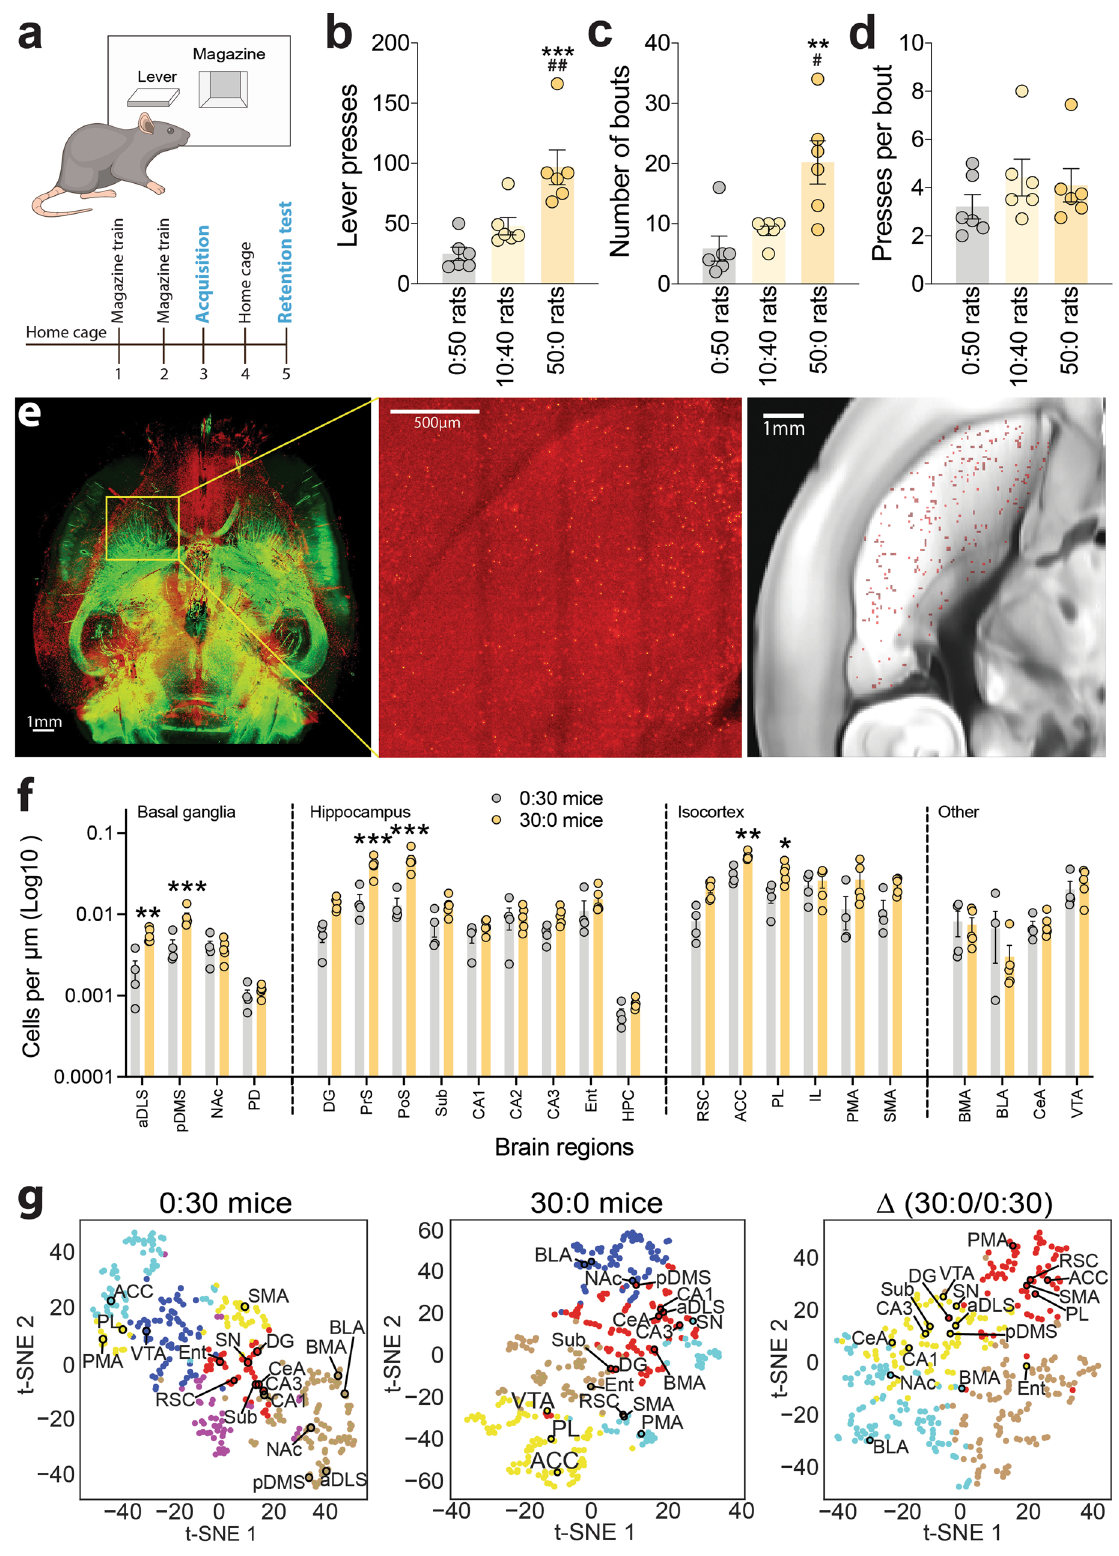
retention test (Supplementary Fig. 5). There was a trend for increased bout frequency in FR2-Chow mice compared with FR1- Chow mice, which did not achieve statistical signi fi cance (Supplementary Fig. 5). However, bout density was markedly increased in FR2-Chow mice compared with FR1-Chow mice (Supplementary Fig. 5). These data suggest that that